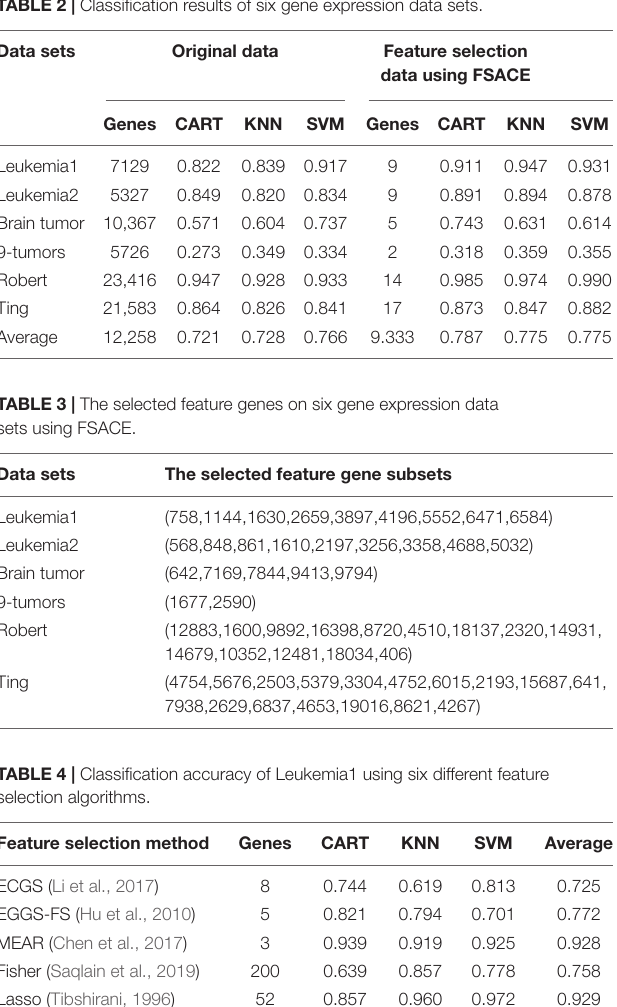
TABLE 2 | Classification results of six gene expression data sets.